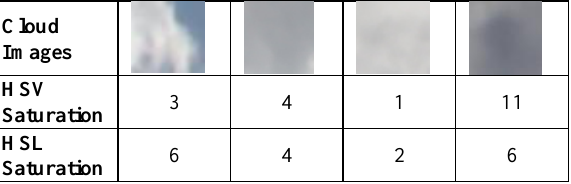
Table 3. Saturation values for cloud image regions